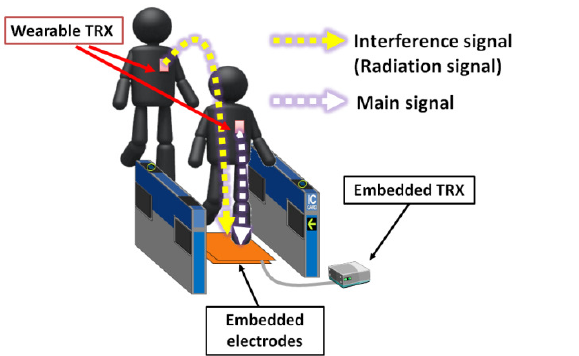
Figure 2. Signal interference in ticket gate system.